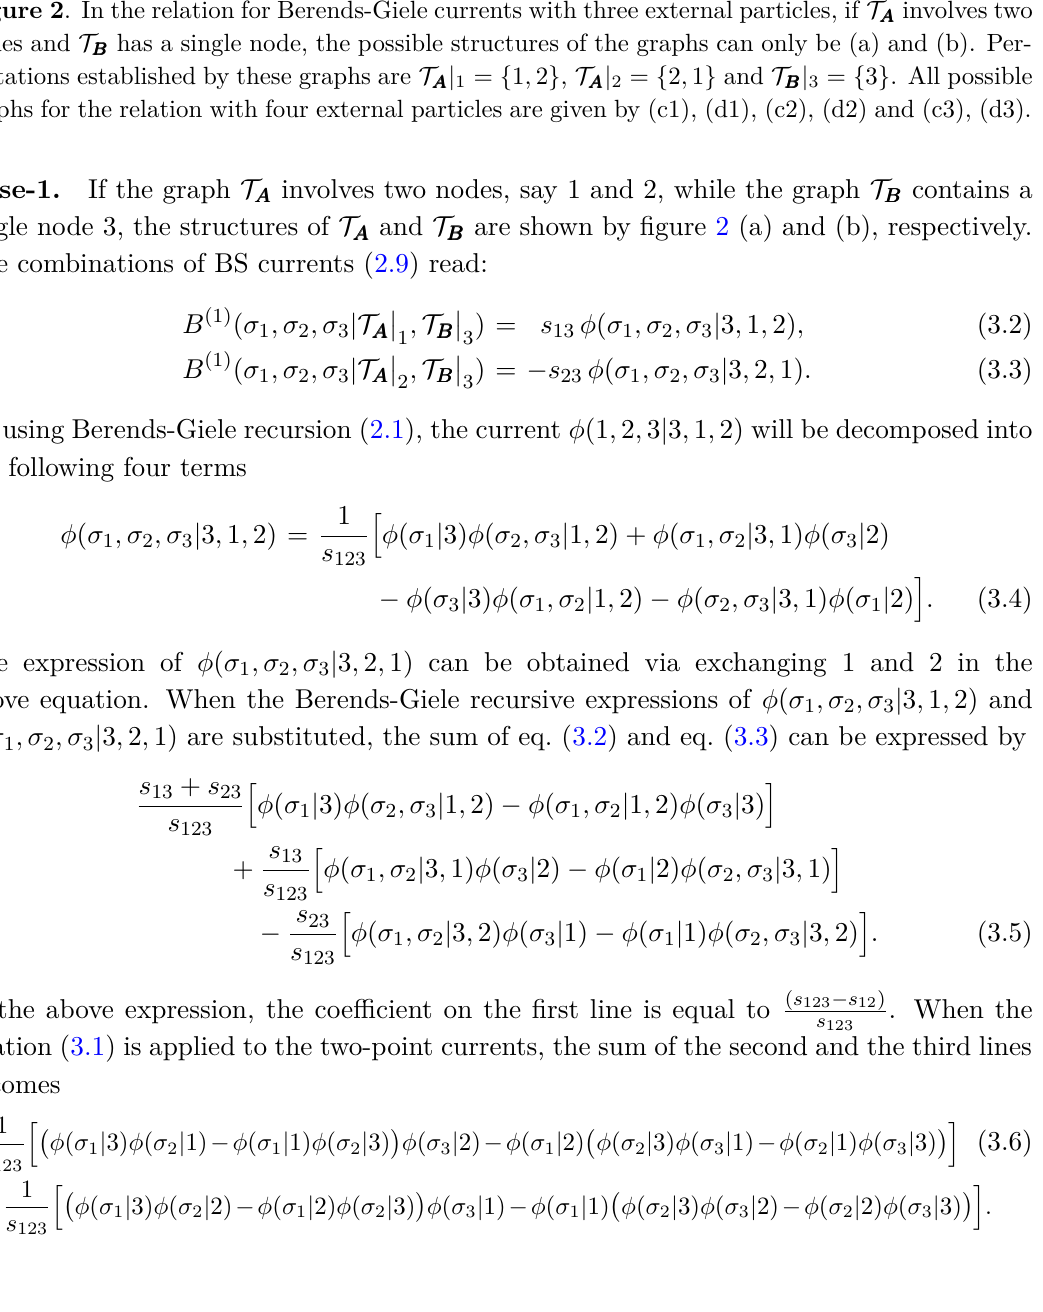
= { 1 , 2 } , T = { 2 , 1 } and T = { 3 } . All possible AAA | 1 AAA | 2 BBB | 3